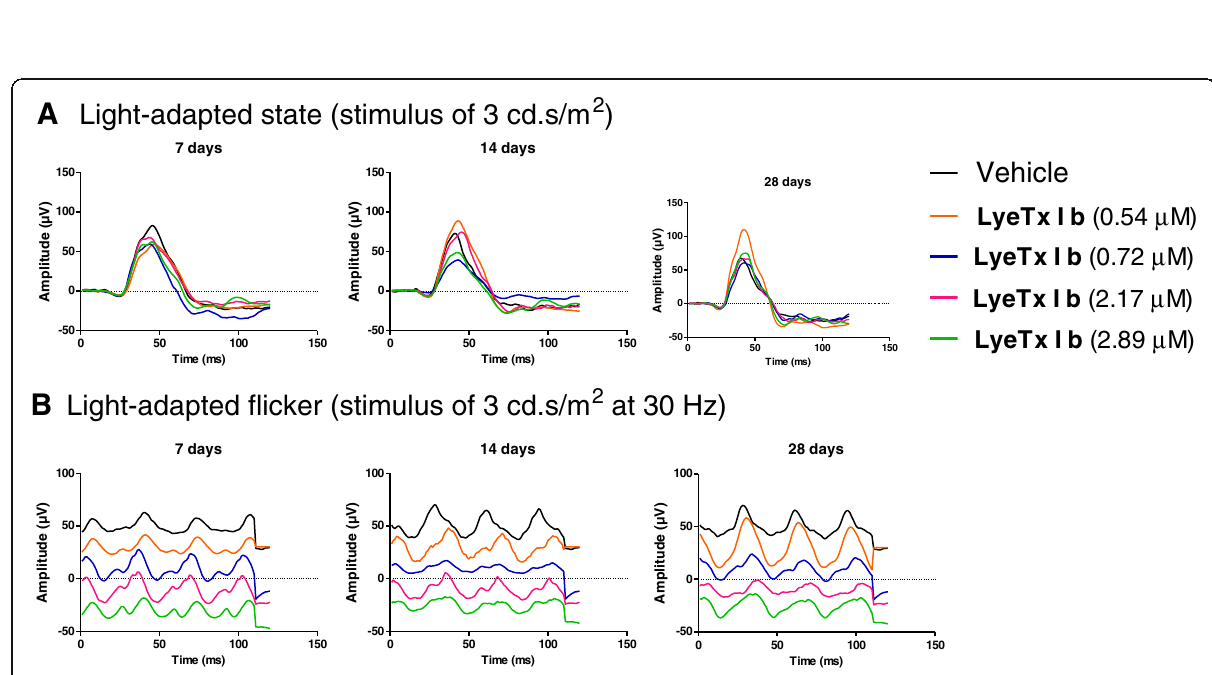
Fig. 5 Representative ERG recordings of rabbit eyes injected with different doses of LyeTx I b at different time points ( a ) light adapted (3.0 cd.s/ m 2 ) ( b ) light-adapted flicker (stimulus of 3.0 cd.s/m 2 at 30